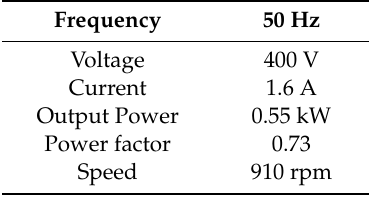
Table 2. Nameplate data of the squirrel-cage induction machine used as SEIG.